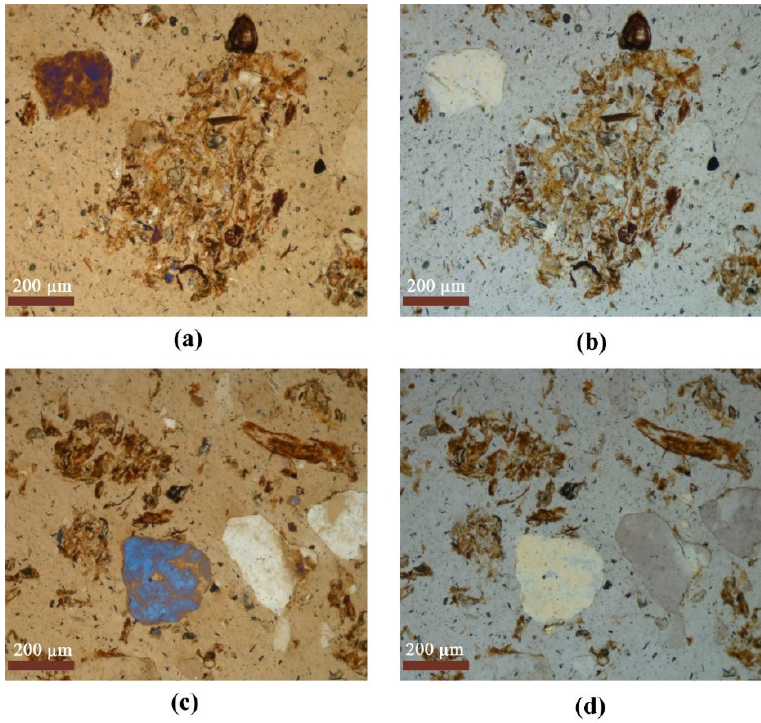
Figure 11. Biogenic aggregates ( a , b ) and fine organic materials ( c , d ). S 2. ( a , c ) Plane polarized light; ( b , d ) crossed polarized light.